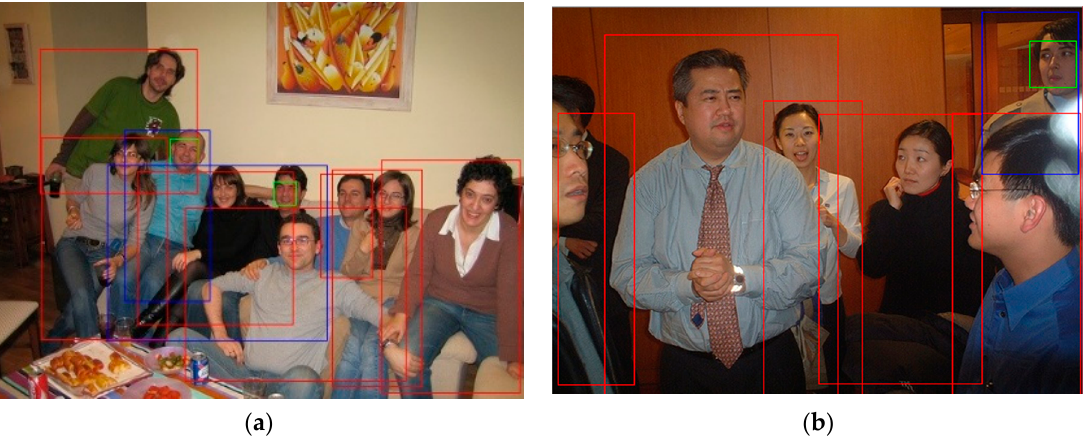
Figure 5. The person is detected and the missed detected bounding boxes are restored. ( a ) Face boxes overlapping any human box are restored to their corresponding non-maximum suppression (NMS)-missed-out boxes; ( b ) face boxes not within any human box are restored to their corresponding NMS-missed-out box.